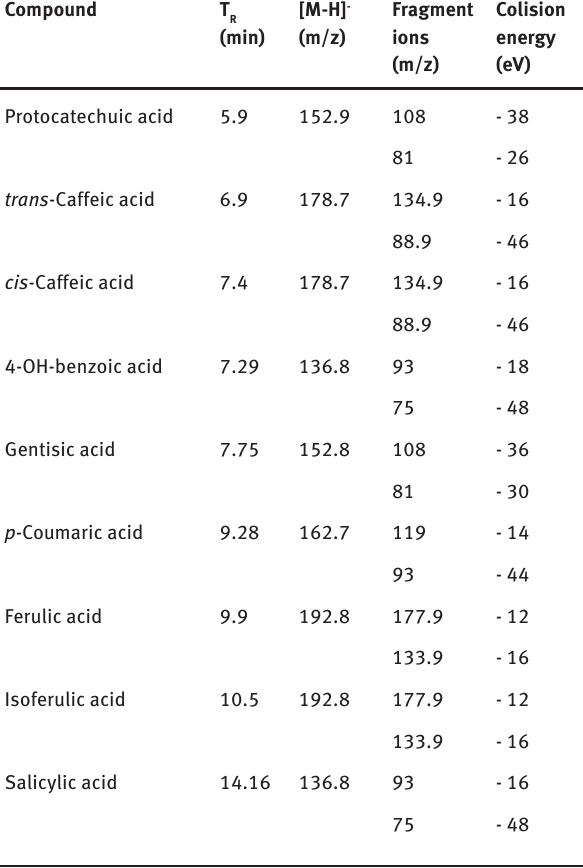
Table 1: LC-ESI-MS/MS analytical results of phenolic acids investigated in samples. Compounds confirmed by comparison with authentic